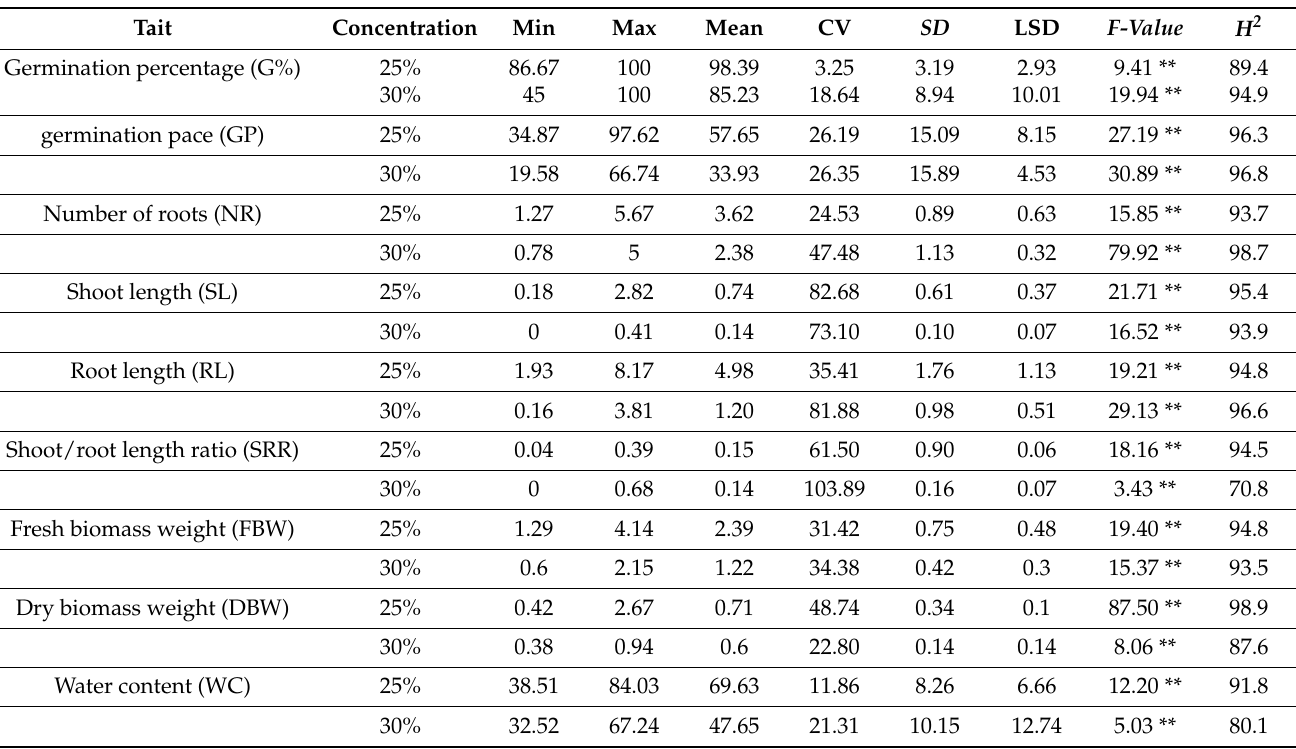
Table 3. Minimum (Min), maximum (Max), mean, least significant differences (LSD), F-value (among genotypes), coefficient of variation (CV), phenotypic standard deviation (SD), and broad- sense heritability (H 2 ) under two PEG-6000 concentrations on 41 spring wheat